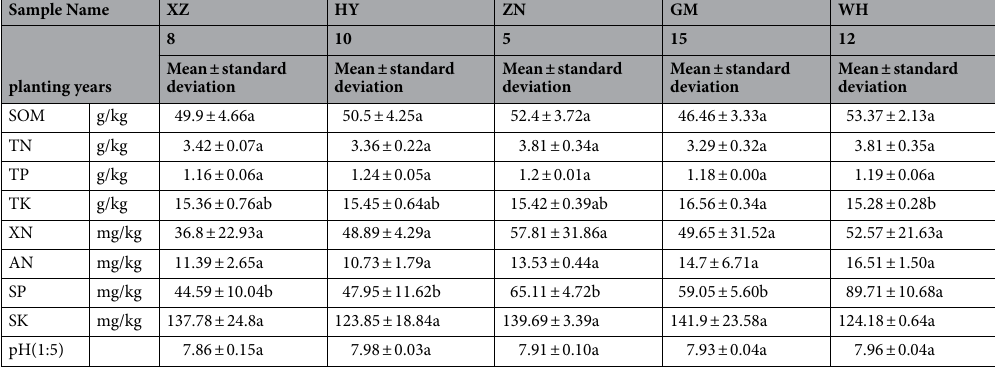
Table 2. Determined results of soil physicochemical properties. The data in the same row with different lower case letters denote that there is significant difference between the groups ( P < 0.05). SOM soil organic matter content, TN total nitrogen content in soil, TP total phosphorus content in soil, TK total potassium content in soil, XN nitrate nitrogen content in soil, AN ammonium nitrogen content in soil, SP available phosphorus content in soil, SK available potassium content in